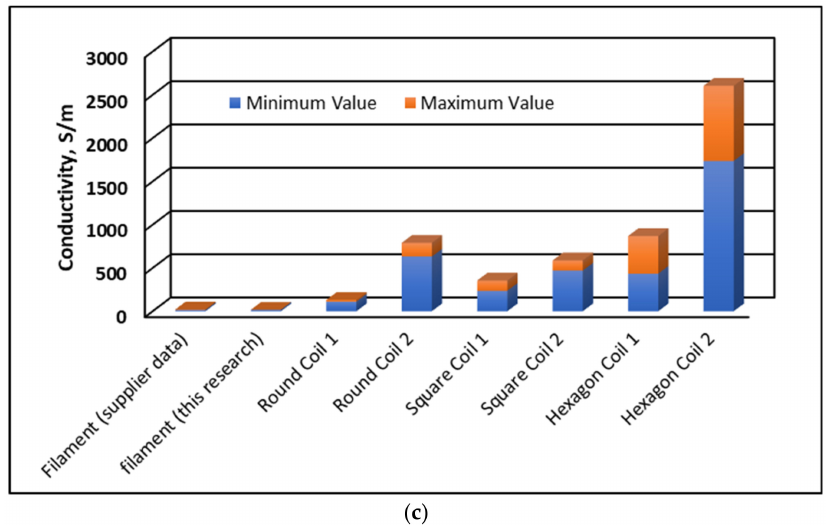
Figure 6. Evolution of electrical properties with coils type and dimensions; ( a ) electrical resistance R , ( b ) resistivity ρ , and ( c ) conductivity σ .